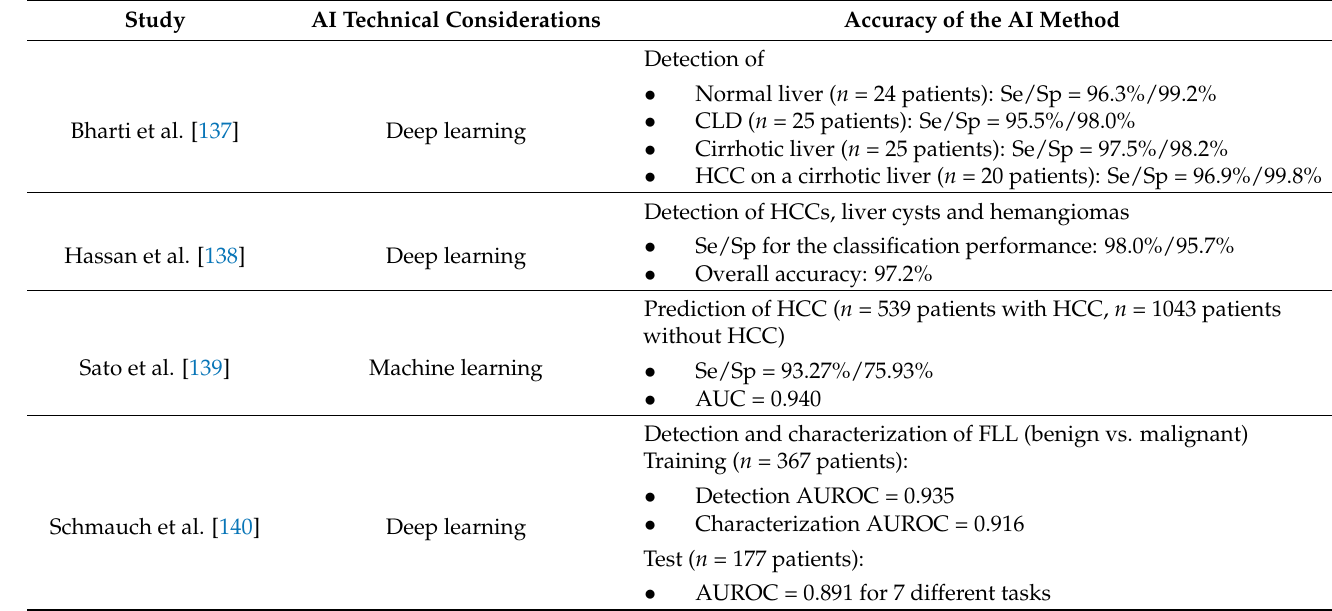
Table 5. A brief overview upon a selection of recent studies that evaluate the potential of AI techniques in the detection of HCC and NAFLD-related